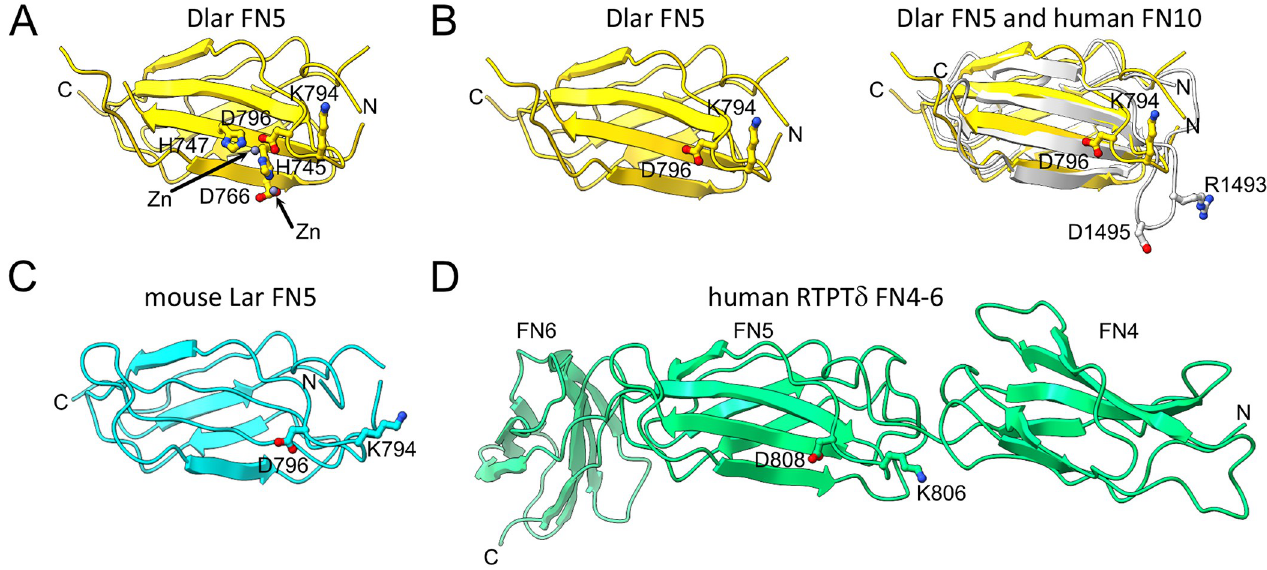
Fig 6. Crystal structures of Dlar and vertebrate orthologues showing the positions of the KGD tripeptide. (A) Ribbon diagram depicting the structure of the FN5 domain of Dlar (yellow). The lysine (K794) and aspartate (D796) residues of the KGD tripeptide are shown in ball-and-stick representation with nitrogen and oxygen atoms colored blue and red, respectively. The two zinc ions bound to Dlar FN5 are shown as gray spheres, and Zn 2+ -binding residues H745, H747, and D766 are shown in ball-and-stick representation. (B) A ribbon diagram of DlarFN5 is shown on the left without the Zn 2+ ions and Zn 2 + -binding residues for the sake of clarity. On the right, this domain is superimposed onto the tenth FN repeat of human fibronectin (white, PDB ID 1FNF). The arginine and aspartate residues of the RGD tripeptide are shown in ball-and-stick representation. Note that these residues are found in a loop that extends away from the FN domain unlike the position of the KGD motif in Dlar. (C) A ribbon diagram of the FN5 domain of mouse Lar is shown in cyan. Residues in the mouse Lar KGD motif are shown in ball-and-stick representation. (D) The crystal structure of domains FN4-FN6 of human RPTP δ is shown in a ribbon representation and colored green. The lysine and aspartate residues found in the KGD motif are shown in ball-and-stick representation. In all panels, the letters N and C indicate the positions of the N and C termini, respectively.